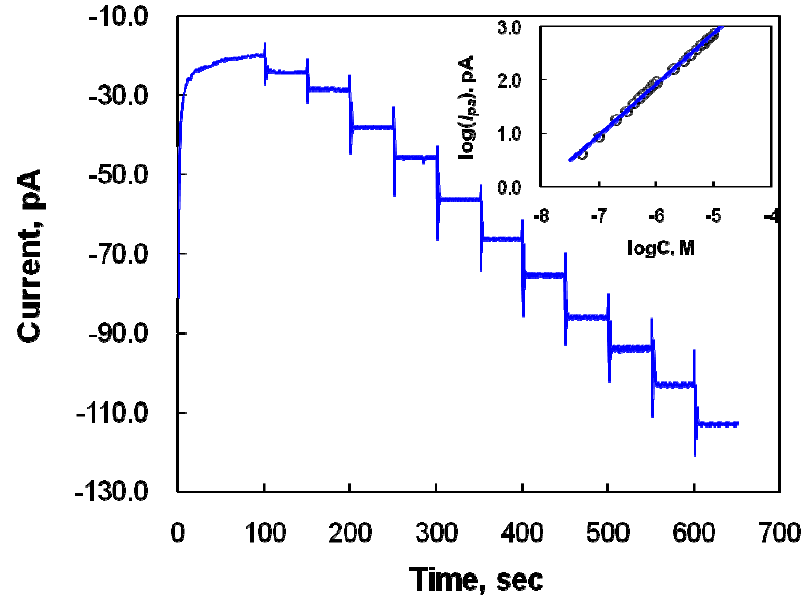
Figure 4. Amperometric response of DA concentrations of 0.05, 0.1, 0.2, 0.3, 0.4, 0.5, 0.6, 0.7, 0.8, 0.9, and 1.0  M (a-k, respectively) at the modified microelectrode in a PBS solution at pH 7.4. The current was measured at a constant potential of 0.2 V corresponding to the DA oxidation potential. Inset: calibration plot (logI vs. logC DA obtained from amperometric